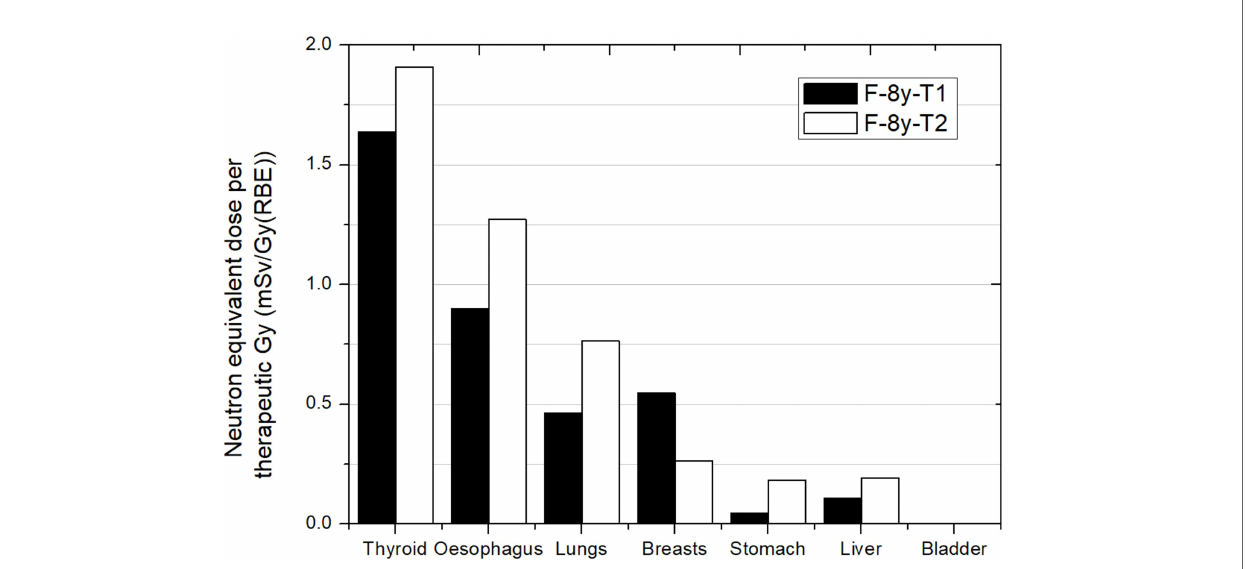
FIGURE 3 | Neutron equivalent doses per therapeutic Gy in selected organs for 2 different brain treatments in the same passive scattering proton beam facility. T1 corresponds to an irradiation with a lateral incidence and a target volume of 514 cm 3 . T2 corresponds to an irradiation with an oblique-inferior incidence and a target volume of 306 cm 3 . Equivalent doses in bladder were too low for the plot scale. Data extracted from Zacharatou-Jarlskog et al.